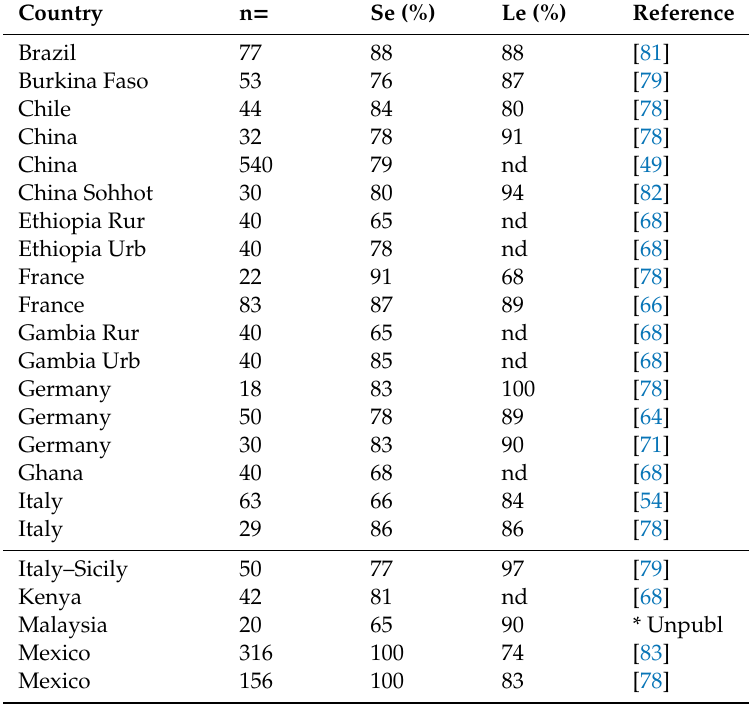
Table 1. Overview of geographical distributions of Secretor (Se) and Lewis (Le)